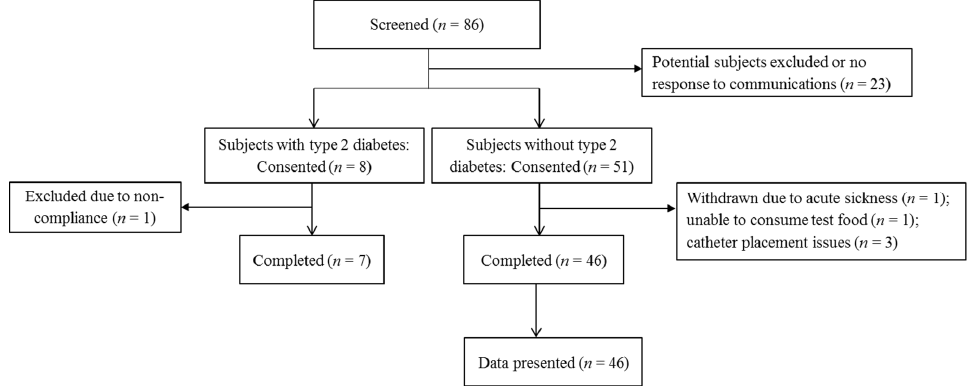
Figure 1. Subject recruitment flow chart.